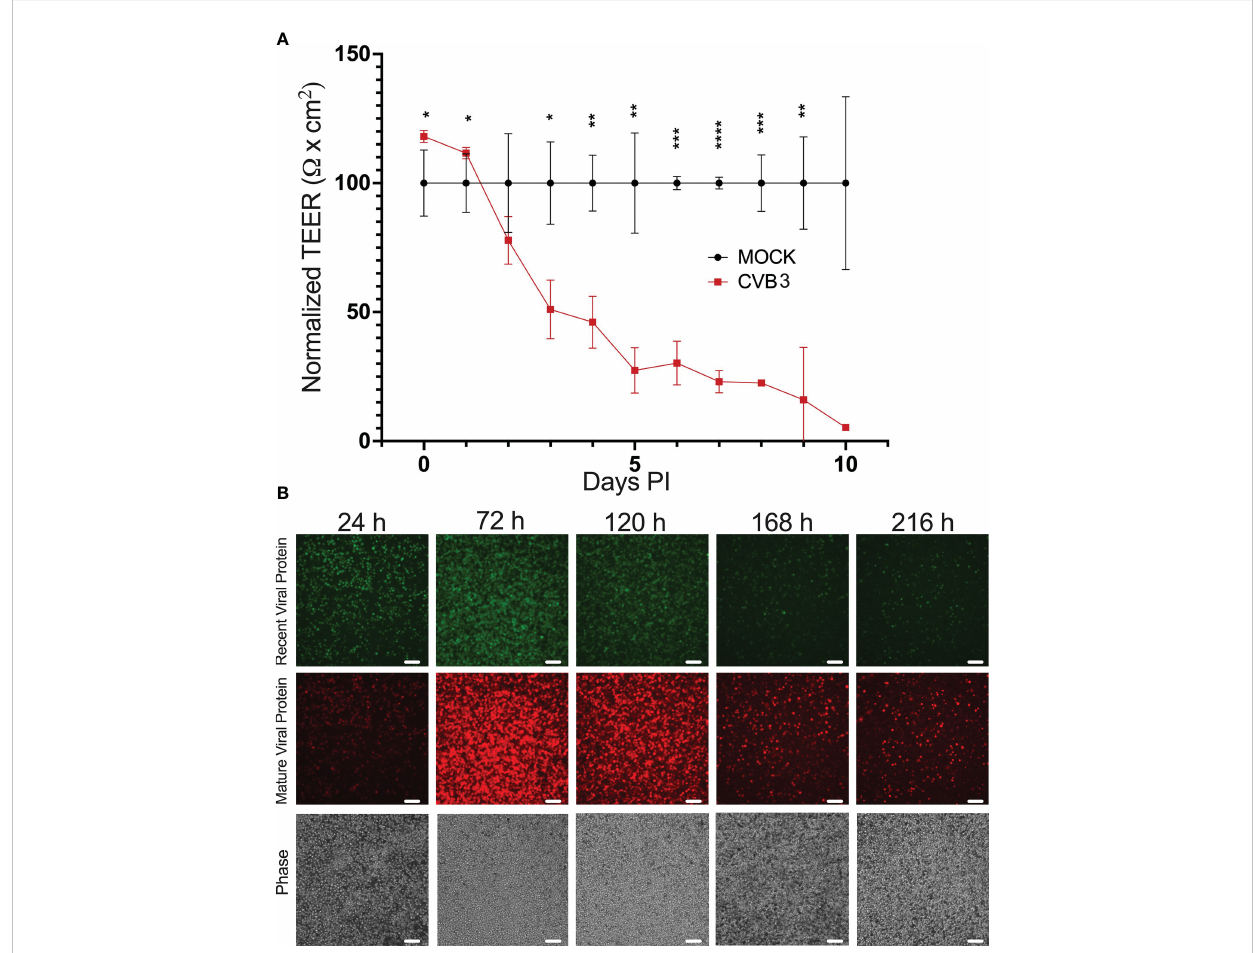
FIGURE 3 CVB3 infection of iBECs leads to eventual loss of transendothelial electrical resistance. iBECs were infected with CVB3 at MOI 10 for the durations indicated. (A) Transendothelial electrical resistance (TEER) in iBECs either infected with eGFP-CVB3 at MOI 10 or mock treated with equivalent volume DMEM. Relative TEER reading for virally-infected group was normalized to mock-infected group at each timepoint. (B) Fluorescence microscopy images of iBECs infected with Timer-CVB3 at MOI 10 for indicated timepoints. Green fl uorescence, red fl uorescence, and phase contrast panels are of the same fi eld for each timepoint. Scale bars= 100 µm. (*p<0.05, **p<0.01, ***p<0.001, ****p<0.0001; student ’ s t -test; n=3. Error bars represent standard